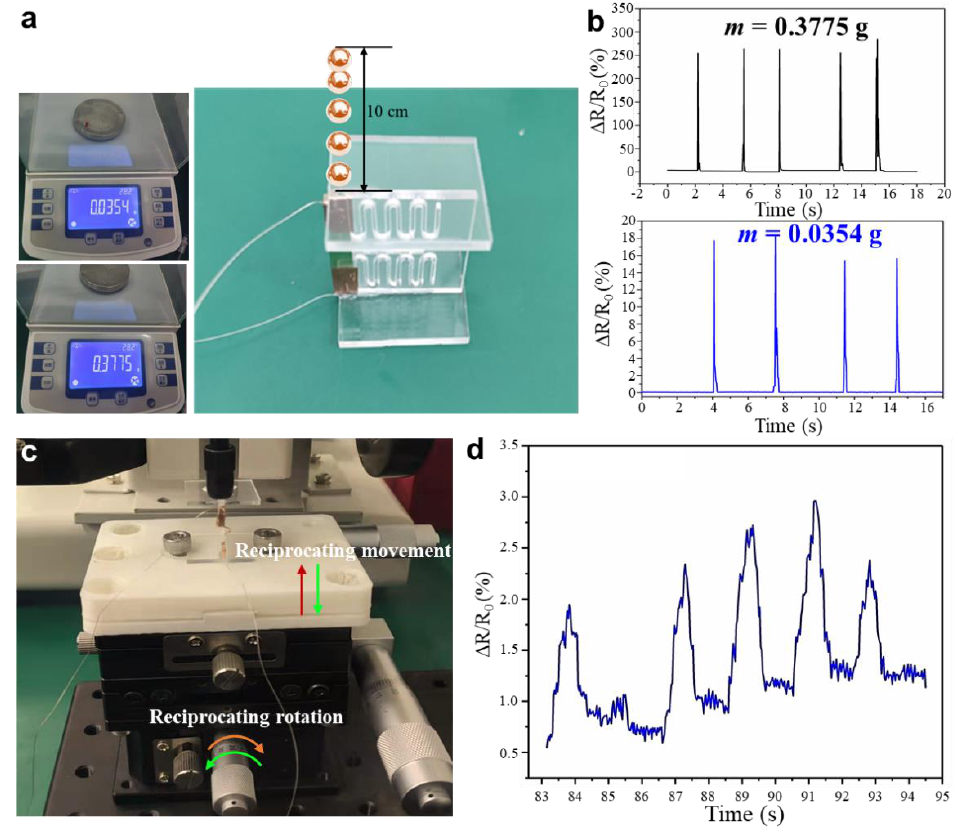
Figure 10. The sensitivity of slit-based mechano-sensor to the dynamic mechanical signal. ( a ) The impact-response experiment of two small particles falling on the substrate. ( b ) The resistance response of slit-based mechano-sensor to different impact signals. ( c ) The displacement loading using a precision displacement table. ( d ) The resistance response of slit-based mechano-sensor to displacement signal.